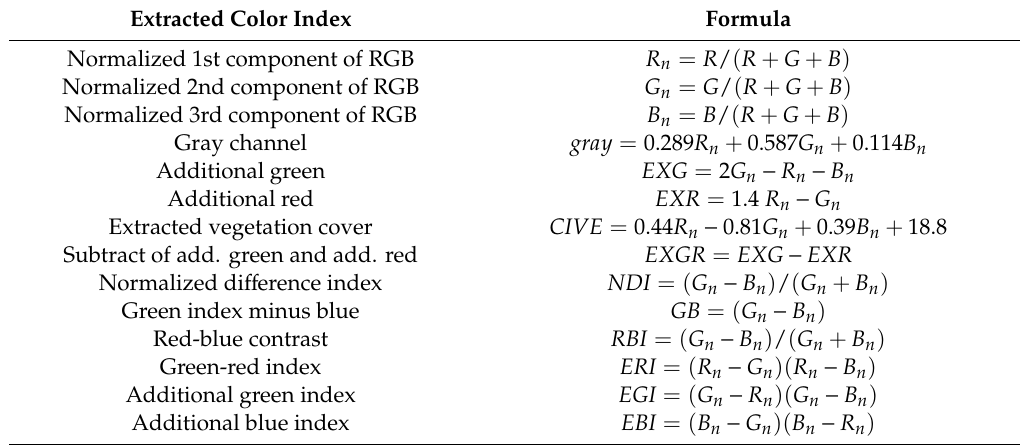
Table 1. Color features used in the study related to vegetation indices. Extracted Color Index Formula Normalized 1st component of